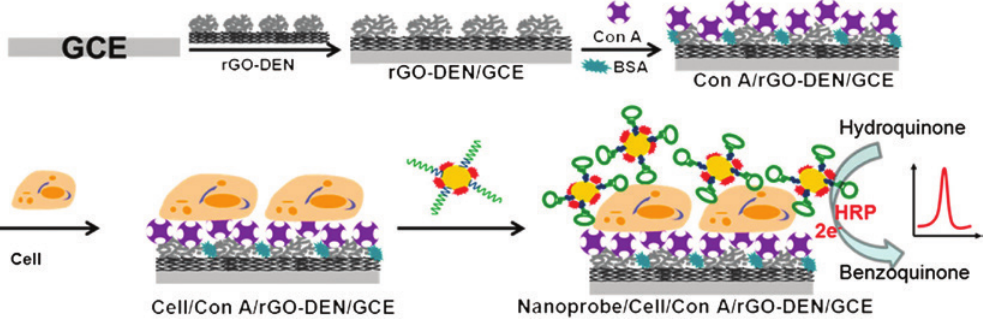
Figure 4: Schematic illustration of the cytosensor based on multivalent recognition and dual signal amplification. Reprinted with permission from (Chen et al. 2014b). Copyright (2014) American Chemical